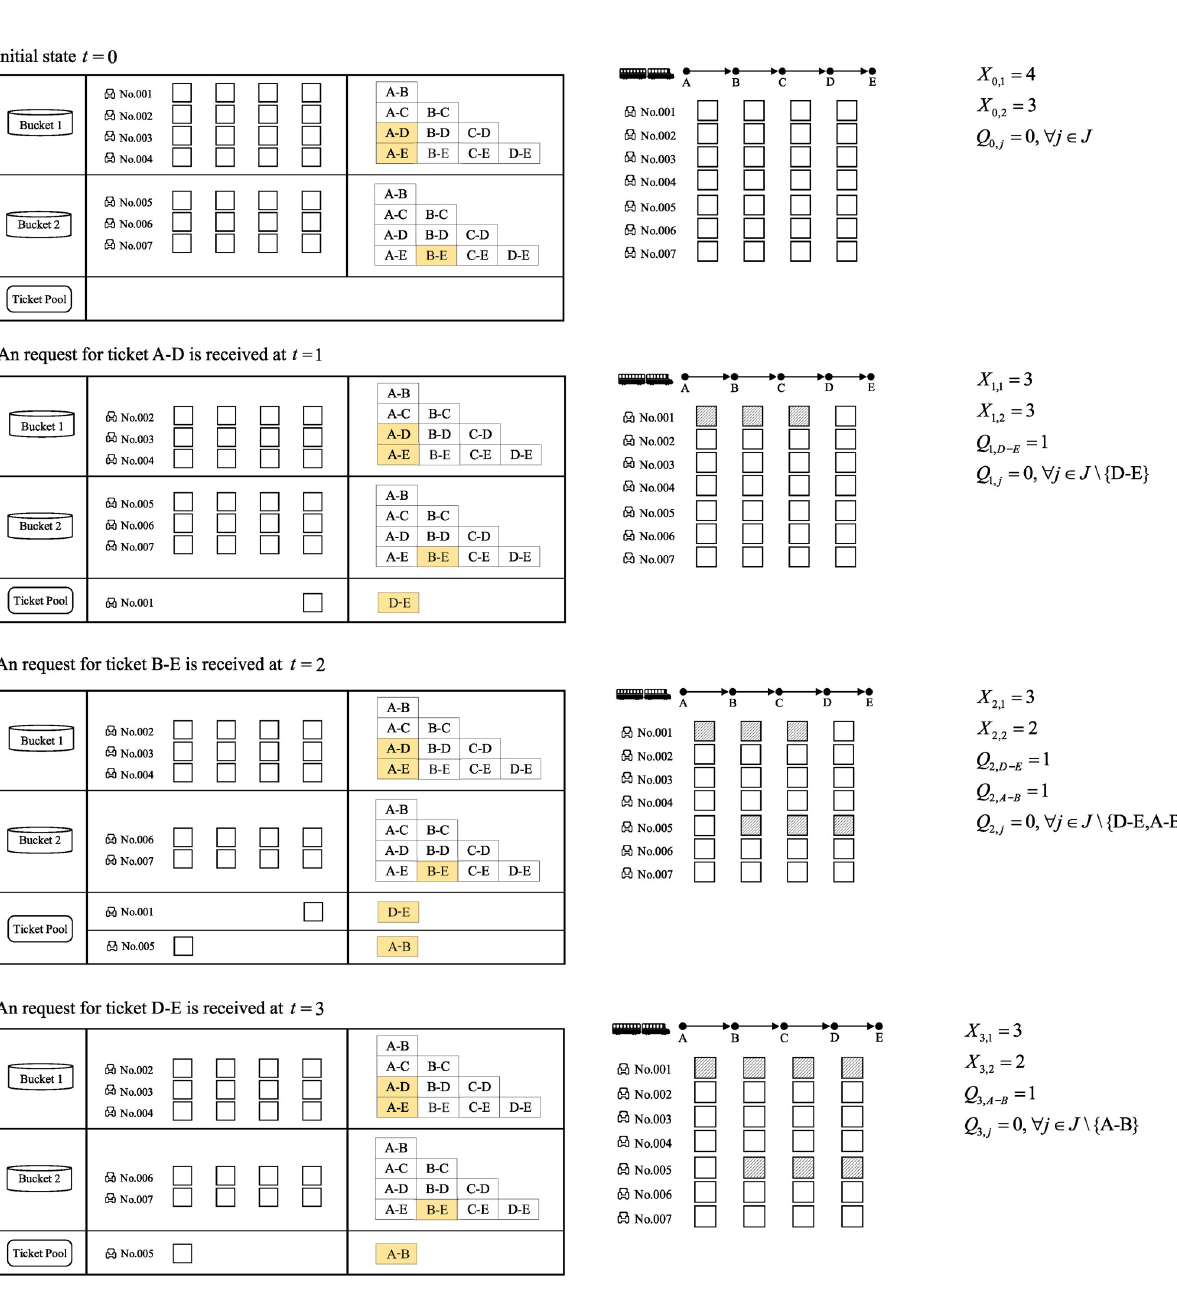
Fig 9. An illustration of the state transition in the DTMC